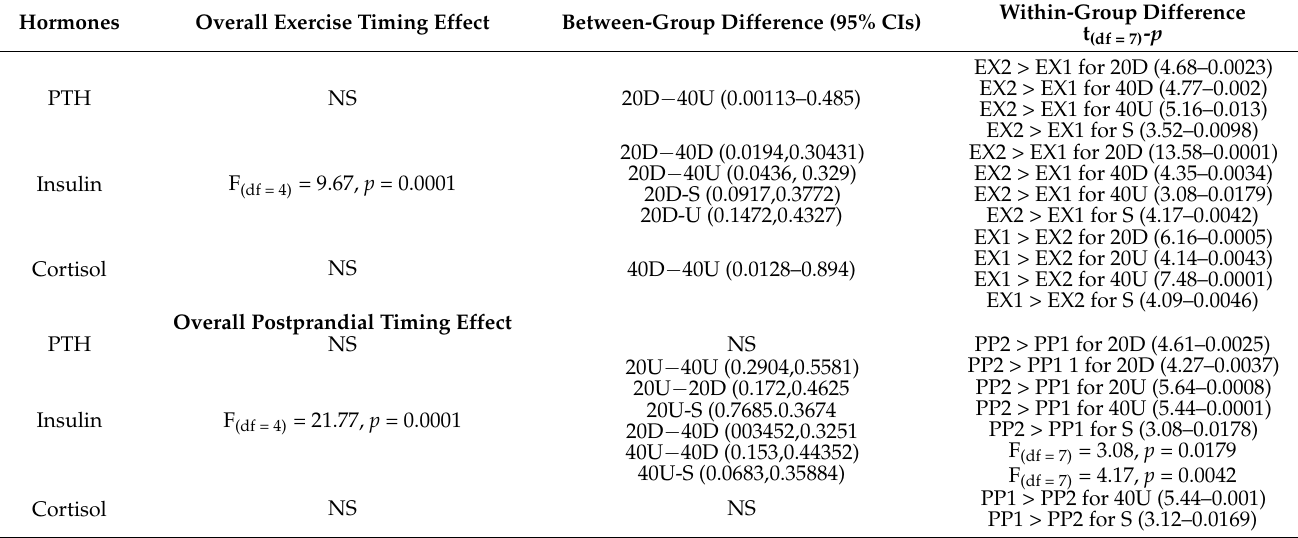
Table 8. Between group and within-group timing differences in exercise and postprandial AUCs.